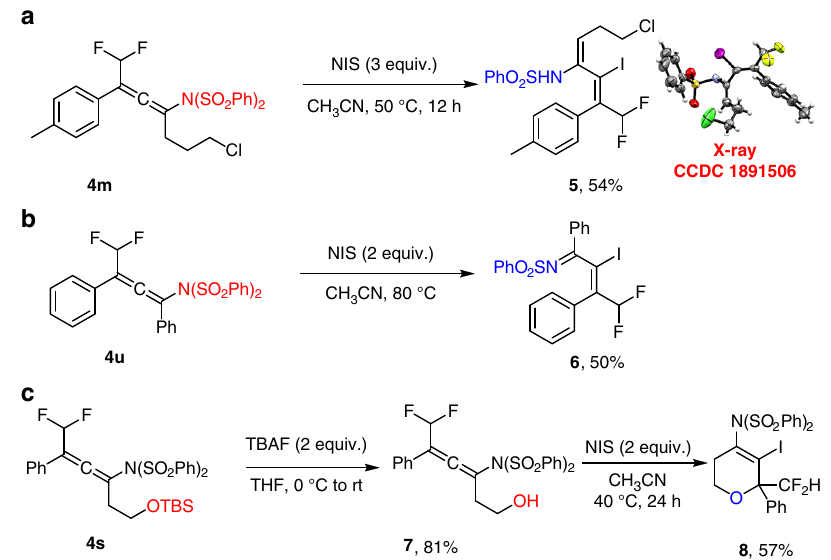
Fig. 3 Synthetic applications. a Derivatizations of di fl uoromethylated allene 4m . b Derivatizations of di fl uoromethylated allene 4u . c Synthesis of multisubstituted 3,6-dihydro-2 H -pyran 8 from di fl uoromethylated allene 4s